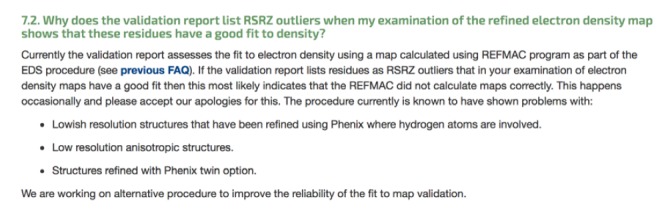
DOI:
http://dx.doi.org/10.7554/eLife.22567.024